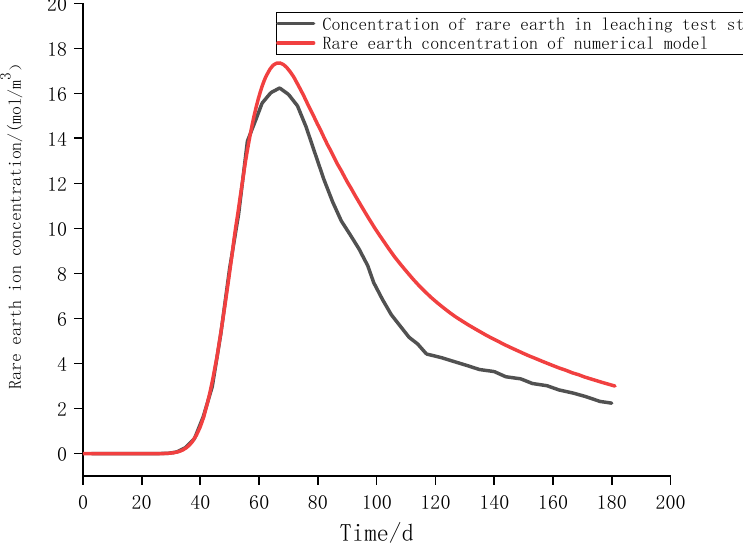
Figure 13. Time–history curve of the rare earth ion concentration at the lower boundary. The cloud diagram of the rare earth ion migration profile at different times is shown in Figure 14. Different colors in the profile image represent different concentrations of rare earth ions, and the concentration of rare earth ions increases as the color of the image changes from blue to red. With the leaching process, Mg 2+ reaches the reaction particle bed of the model through leaching flow and reacts with the rare earth ions on the particles, and the exchanged rare earth ions migrate downward with the seepage field. The rare earth at the foot of the mountain is leached and migrated by comprehensive injection. With the passage of time, the migration belt moves down and finally completes the leaching of the whole stope. As it is difficult for the leaching solution to reach the ore body below the mountain top, if the liquid collection project is not carried out at the ore body below the mountain top, it is easy to form a liquid injection blind area in this area. It is obvious that the liquid injection sequence is very important, which also proves that the experience of liquid injection from the top to the bottom of the mountain is scientific.